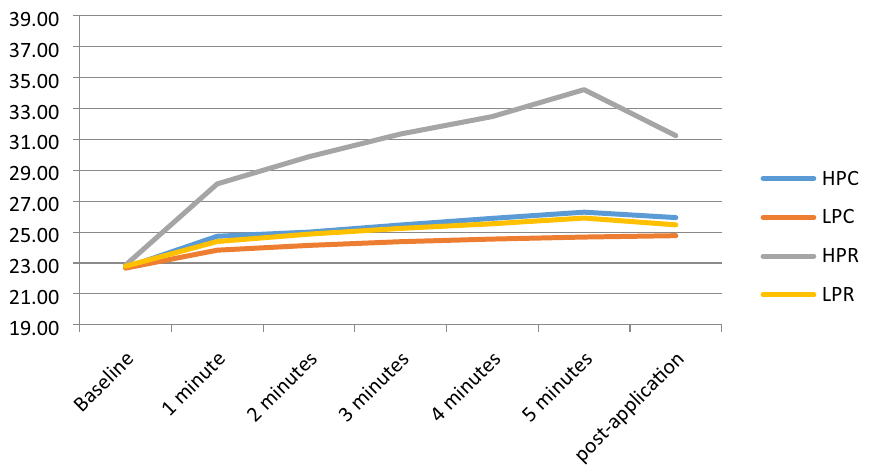
Figure 2. Capsular temperature. HPC high-power capacitive, LPC low-power capacitive, HPR high-power resistive, LPR low-power resistive.